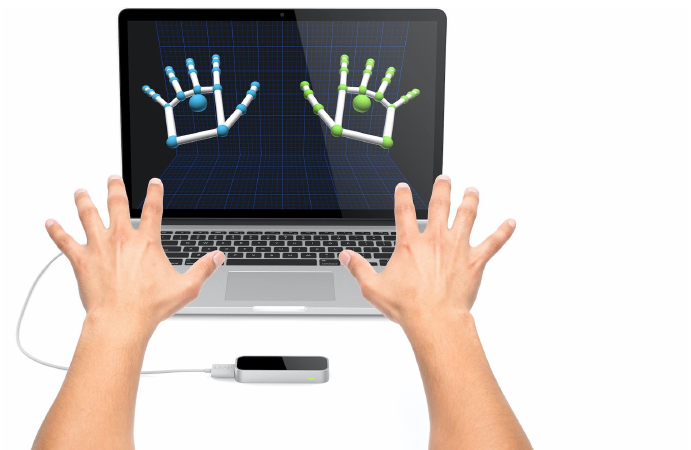
Figure 1. The Leap Motion controller (LMC) device showing a 3-D representation of both